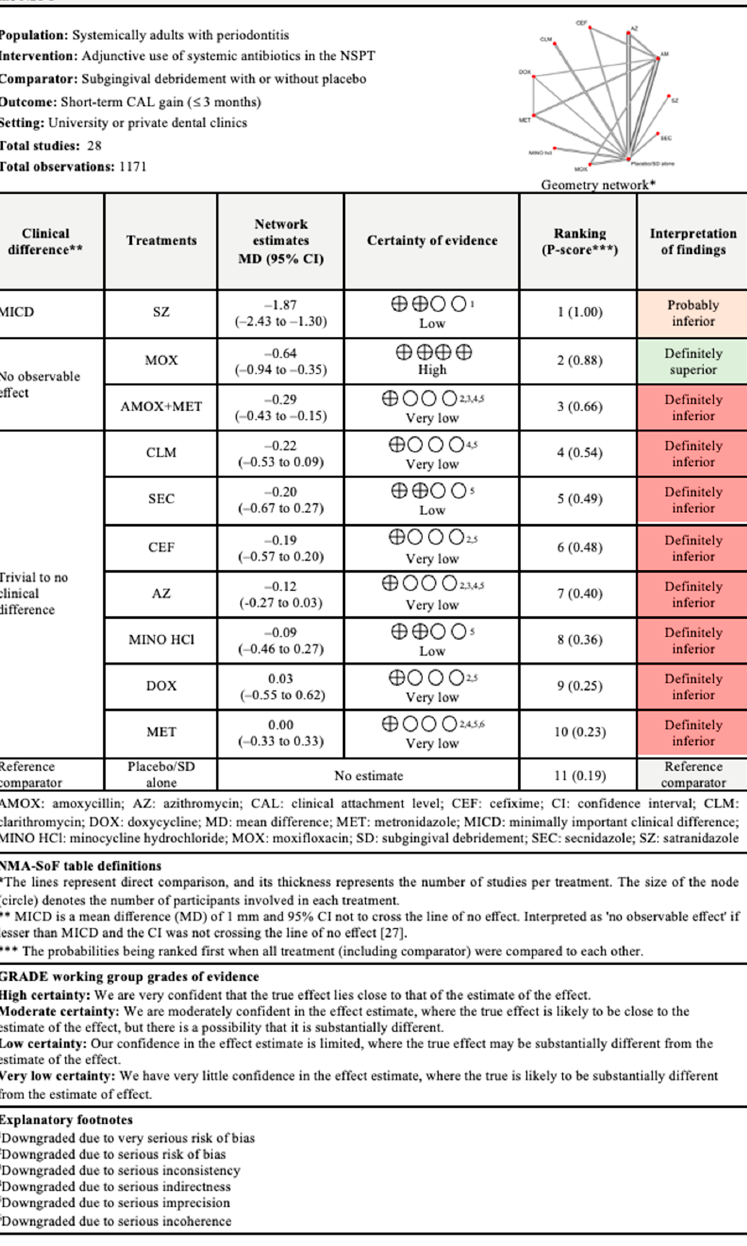
Figure 6. Summary of findings for short-term CAL gain following the use of systemic antibiotics adjunctive to subgingival debridement.